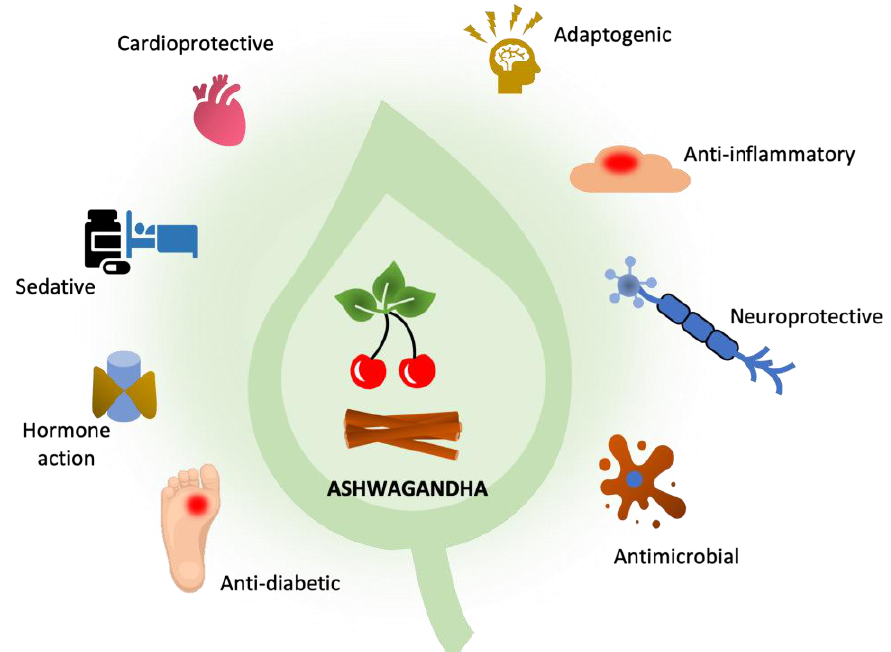
Figure 1. The comprehensive health benefit of Ashwagandha.